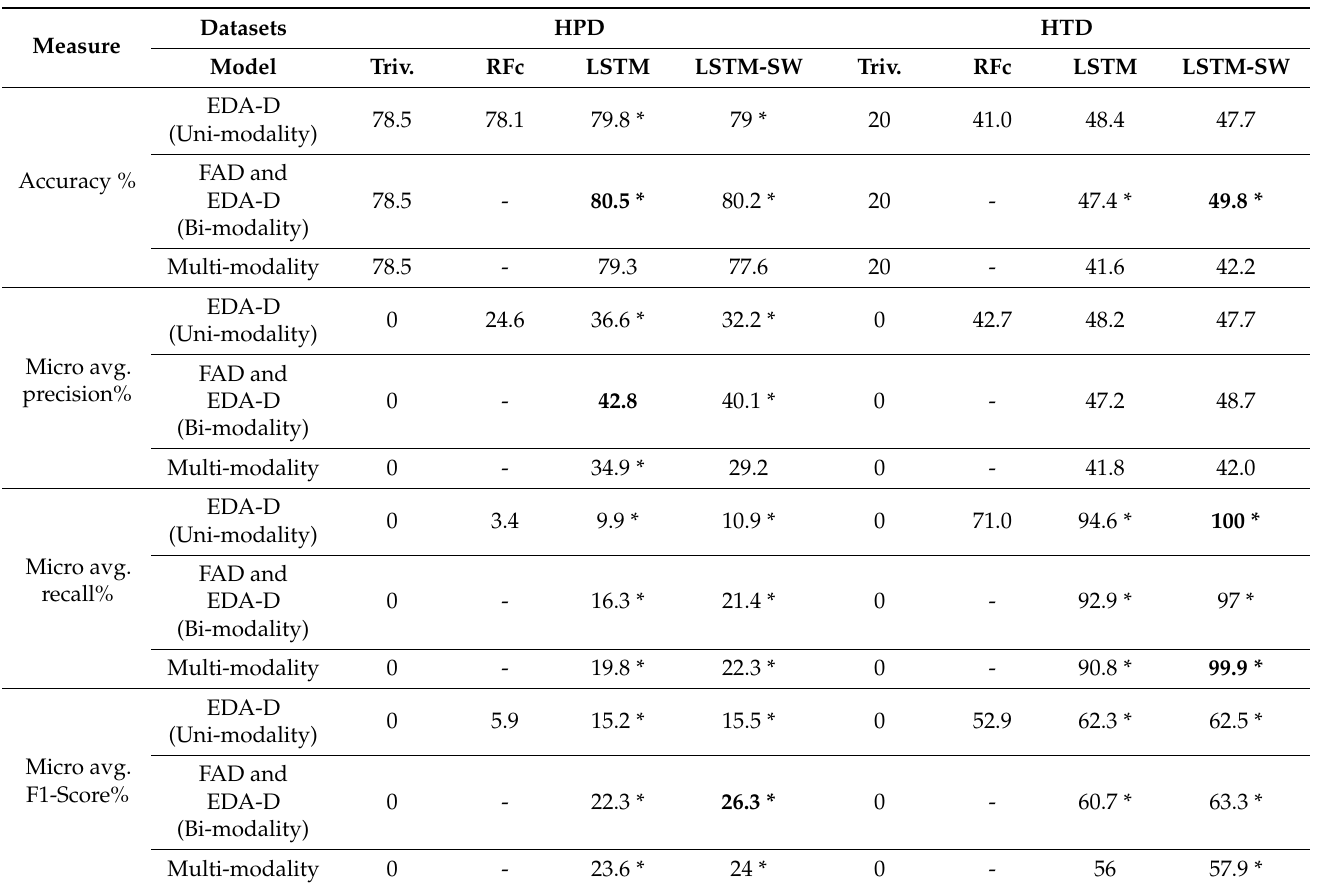
Table 8. Comparison of the best Uni-, Bi-, and Multi-modality models with HTD regarding classifi- cation task. The Bi-modality models. * p < 0.05 when using paired t -test between RFc and LSTMs (LSTM and LSTM-SW). The bold font indicates the best